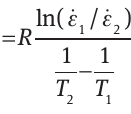
In Figure 9 we present the resulting creep activation energies Q for the Al-Cu matrix composites, as computed C based on Eq. (6). Rather than showing those energy values as a function of the amount of boron, we deemed it more relevant to depict the effect of the amount of particles. The volume percent of AlB (as a function of the level of boron) 2 was previously shown in Table 2. The activation energy values obtained in this work are consistent with those compiled in the critical work by Li and Langdon [10] specifically on AMCs. For instance, Al reinforced with 30 vol% SiC is reported to have a Q ≈23 p C kJ·mol -1 . Nonetheless, despite its self-consistency and low dispersion (small confidence intervals at α = 0.05,